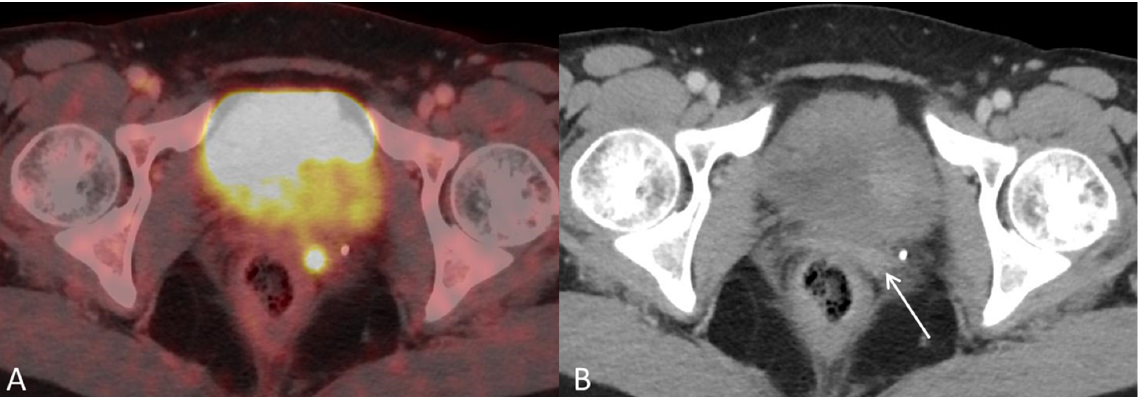
Figure 2. ( A ) Baseline axial PET/CT fused image. The metabolic activity is inhomogeneous, with areas of high to low metabolic activity. ( B ) Contrast-enhanced axial CT shows an enlarged uterus with endometrial thickening and polypoid tumour masses protruding into the uterine cavity. The tumor appears hypodense to the myometrium with signs of myometrial invasion. There was no involvement of the ovaries, fallopian tubes or cervix on either the PET or CT.